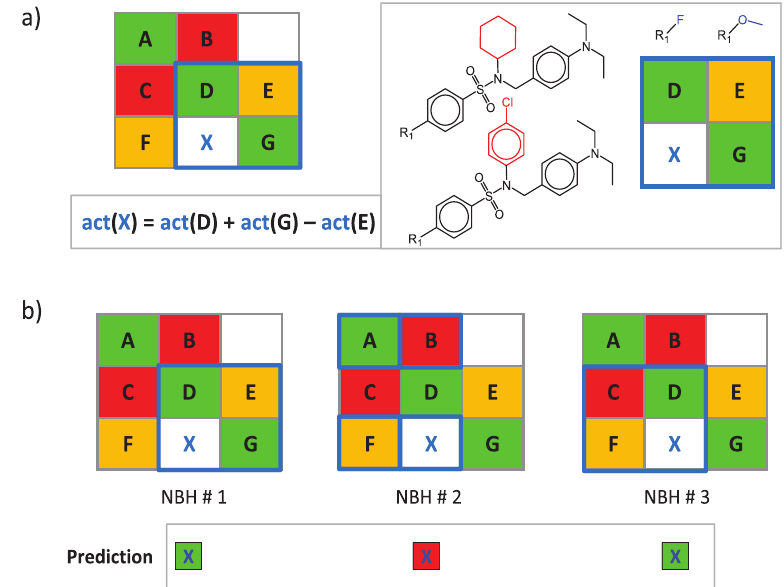
Figure 2. Neighborhood-based activity prediction. ( a ) A NBH of virtual compound X is marked in blue in a model SARM and compounds forming this NBH are displayed. Compounds D and G share the same substituents and core with X, respectively, and the third neighbor E consists of the core of D and substituent of G. At the lower left, the equation to predict the potency of X from the values of D, E, and G is shown. ( b ) The process of NBH mining is illustrated. For X, the set of all qualifying NBHs (marked in blue) in a given SARM are identified and potency values are predicted for individual NBHs (indicated by color-coded squares). “act” stands for activity (in this case, numerical potency values are used).